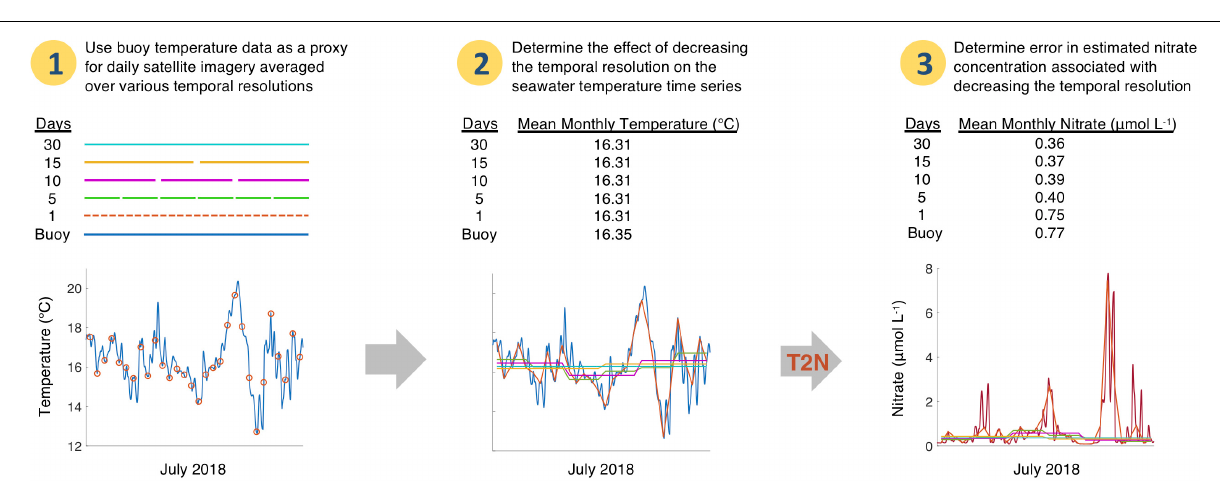
FIGURE 3 | (1) Continuous temperature data (blue line) from a buoy was sampled daily to simulate daily satellite SST determinations (red dots). (2) These daily temperatures are then averaged over four temporal resolutions (5, 10, 15, and 30 days; shown as colored lines plotted over the continuous buoy data). The mean SST across the entire time series for each temporal resolution is shown. (3) Use empirical temperature to nitrate relationship (T2N) to estimate time series of nitrate concentration which are plotted over the continuous estimated nitrate concentration derived from the buoy temperature data (maroon line). The mean estimated nitrate concentration across the entire time series for each temporal resolution is